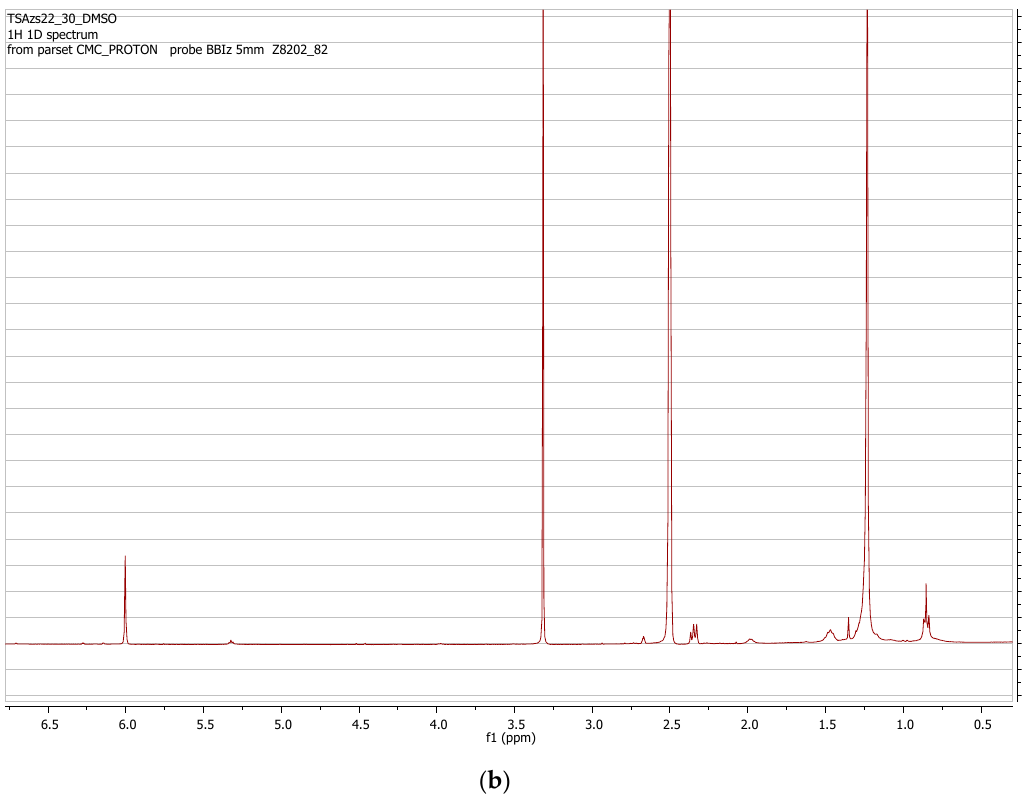
Figure 2. 1 H-NMR spectrum of the fraction containing the isolated ARS in CDCl 3 (up) and in DMSO (down) .